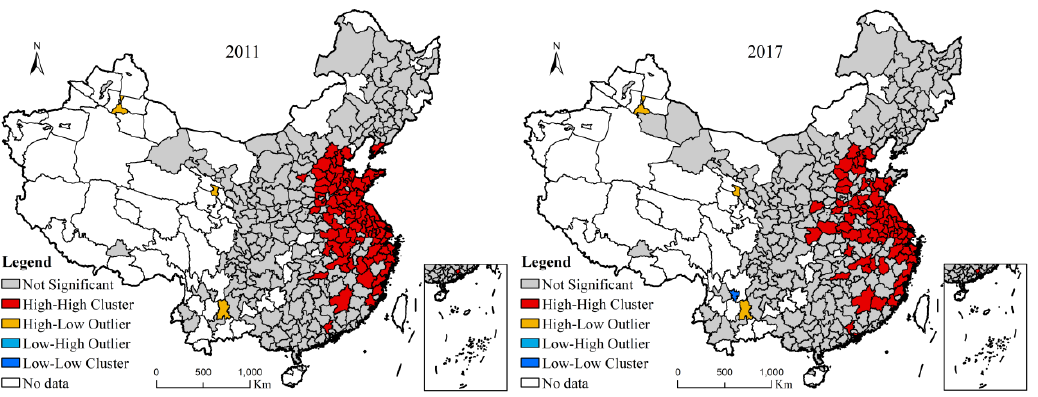
Figure 3. LISA pattern of regional innovation capability.